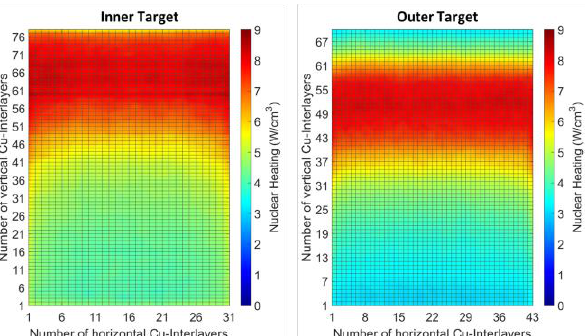
Figure 13. Nuclear heating (W/cm 3 ) distribution on Cu/CuCrZr components of the inner ( left ) and outer ( right ) target, with WCLL blanket.